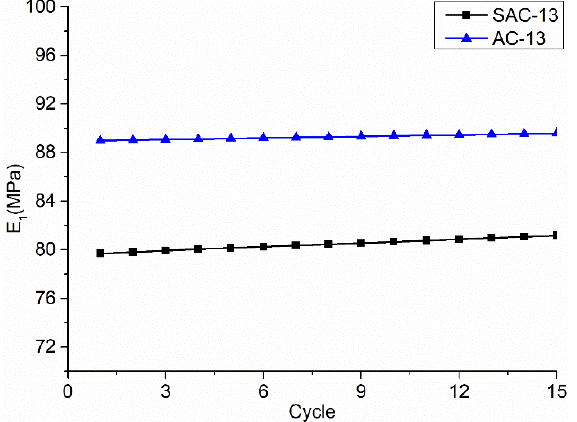
Figure 11. Air voids curves changing with the load cycle times.